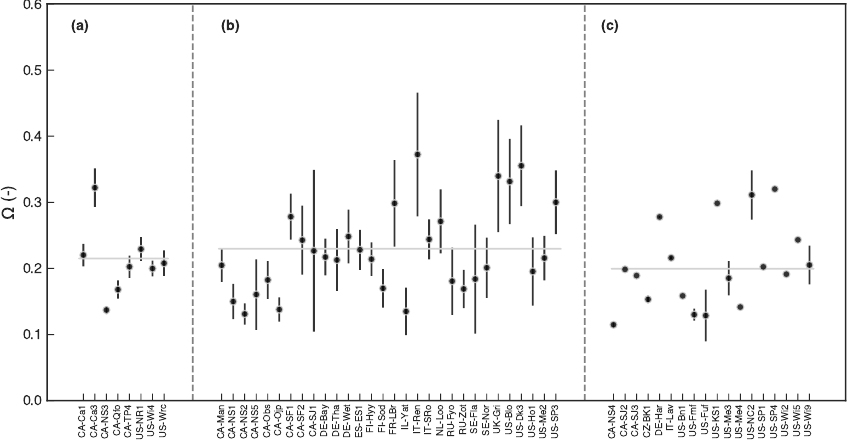
Figure 2. Values of the coupling coefficient ( (cid:127) ) for sites from the evergreen needleleaf forest (ENF) plant functional type. Estimated values of (cid:127) have been split into (a) sites where the coefficient of variation (COV) is < 20%, (b) sites where the COV is > 20%, and (c) sites with only 2 years of data. Site error bars represent 1 standard deviation (site year variation) in estimated (cid:127) values. Solid horizontal grey lines show overall mean coupling